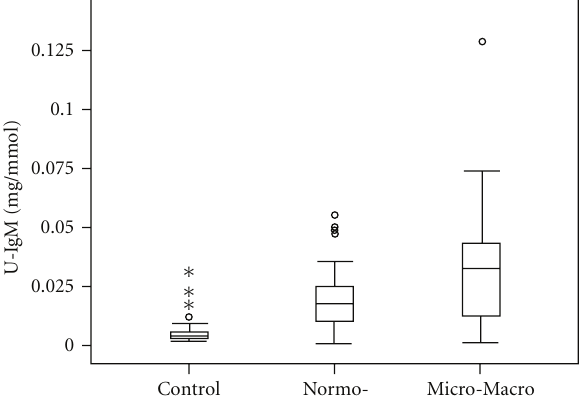
Figure 1: Box-plot of levels of IgM in control subjects compared with patients with normo- and micro- or macroalbuminuria at bas- eline ( P < 0 . 001). Normo- versus micro- or macroalbuminuria ( P = 0 .